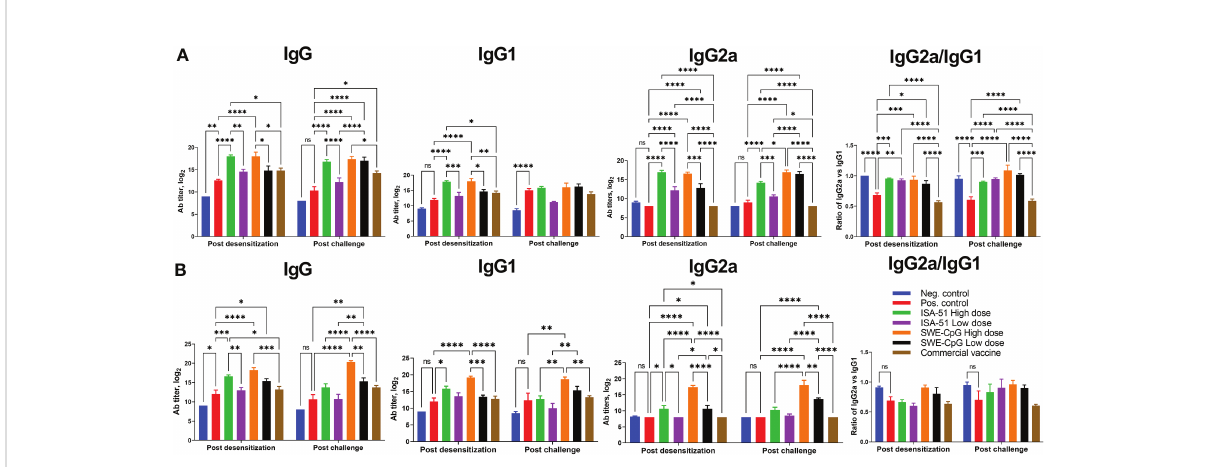
FIGURE 3 IgG, IgG1, and IgG2a ELISA titers as well as the ratio of IgG1 isotype antibodies to IgG2a in serum of BALB/c mice after pre- (A) and co-seasonal (B) ASIT and allergy challenge. ASIT was performed with various vaccine formulations containing high and low dose allergen (Art v 1 protein) and adjuvants (ISA-51 or SWE-CpG). A commercial vaccine group was included for comparison, comprising Artemisia vulgaris pollen extract formulated with aluminum hydroxide adjuvant. Challenge of mice after pre- and co-seasonal ASIT was performed by intranasal administration and nebulization of Artemisia vulgaris pollen extract. Antibody levels are presented as geometric mean titers with 95% con fi dence intervals and expressed in log 2 . Differences in antibody titers between animal groups were assessed using Tukey ’ s multiple comparisons test. A P<0.05 value was considered a signi fi cant difference. *P <0.05, **P <0.01, ***P <0.001, and ****P